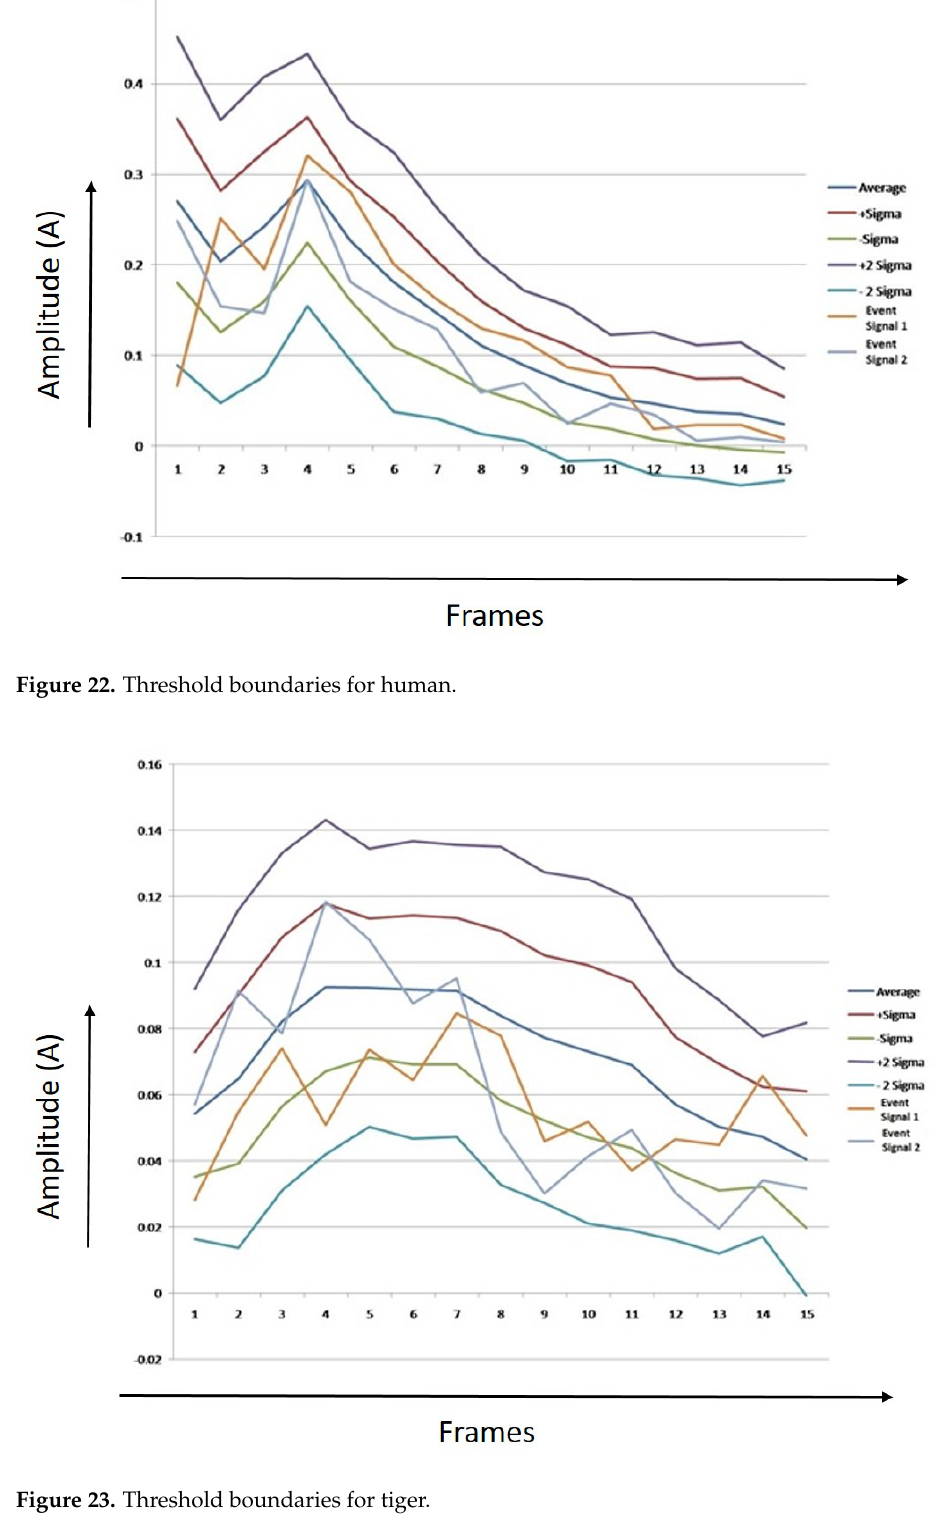
Figure 23. Threshold boundaries for